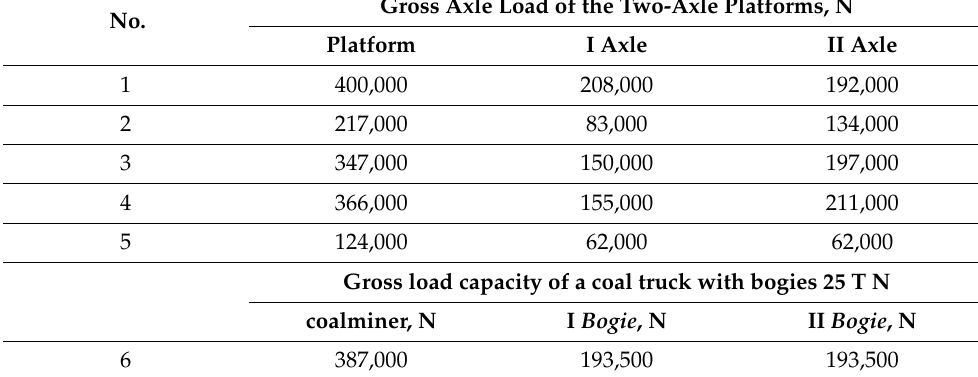
Table 1. Axle loads of individual wheelsets.